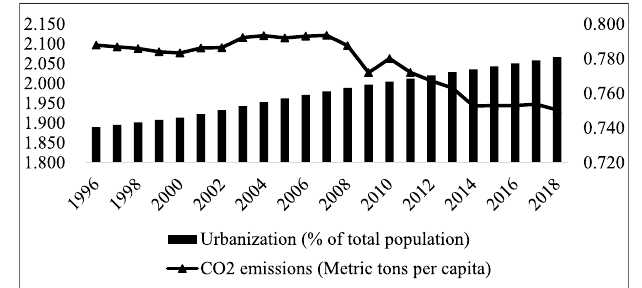
FIGURE2| Thechangesbetweenurbanizationandcarbonemissionsof the OECD countries from 1996 to 2018.